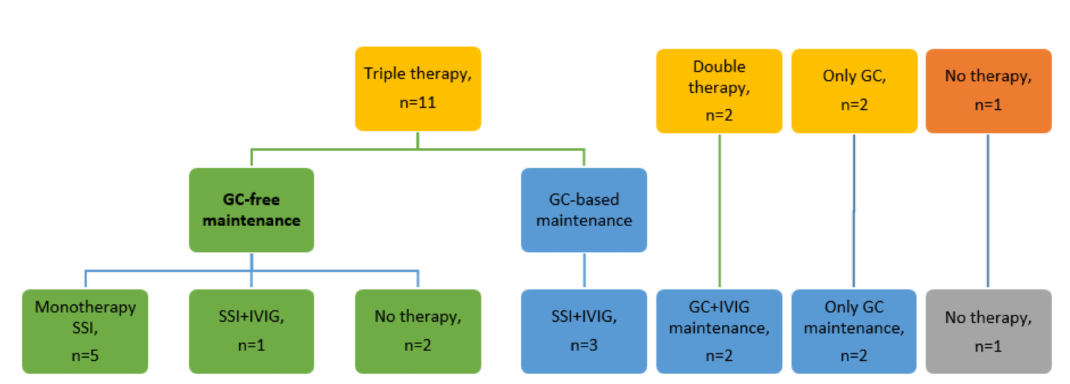
Figure 1. Flow diagram of induction and maintenance therapy. Yellow squares represent the induction therapy; the green and blue ones represent the GC-free and GC-based maintenance, respectively. Legend: GC, glucocorticoids; IVIG, immunoglobulins; SSI, steroid-sparing